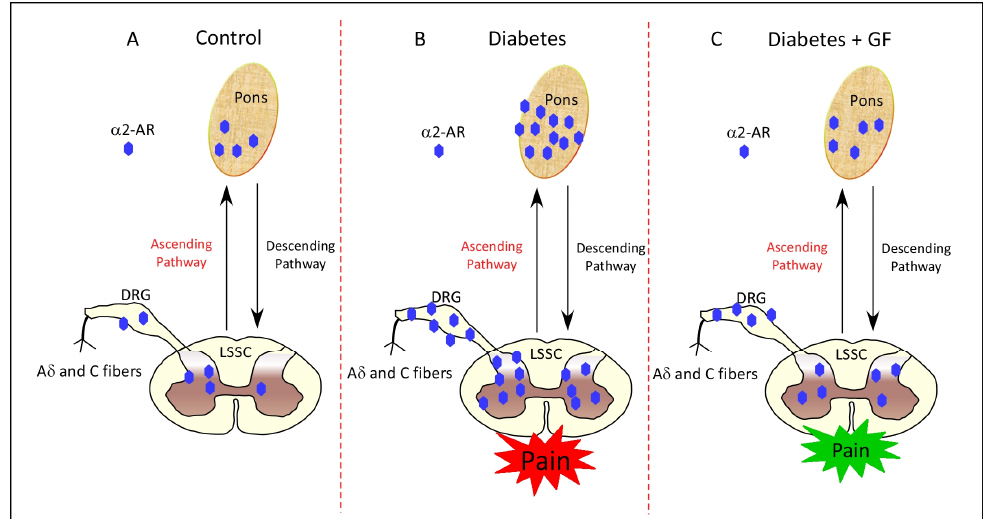
Figure 7. Schematic representation of presynaptic α 2 ‐ AR as a function of diabetes, neuropathic pain and guanfacine treatment. In comparison with the control status ( A ), diabetes augments neuronal expression of presynaptic α 2 ‐ AR in the pons, LSSC and DRG ( B ). Guanfacine administered chronically for two weeks reversed diabetes ‐ induced upregulation of neuronal presynaptic α 2 ‐ AR ( C ). Arrows indicate the ascending/descending pain transmission pathways. Abbreviations: GF, guanfacine; α 2 ‐ AR, alpha ‐ 2A adrenoceptors; LSSC, lumbar segment of the spinal cord; and DRG, dorsal root ganglia.